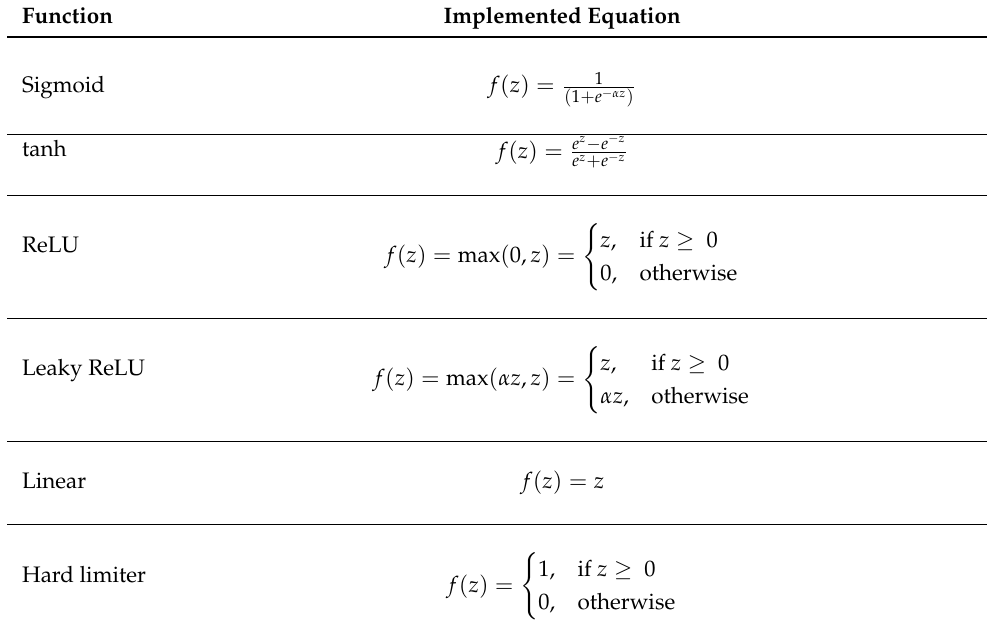
Table 4. Supported activation functions.